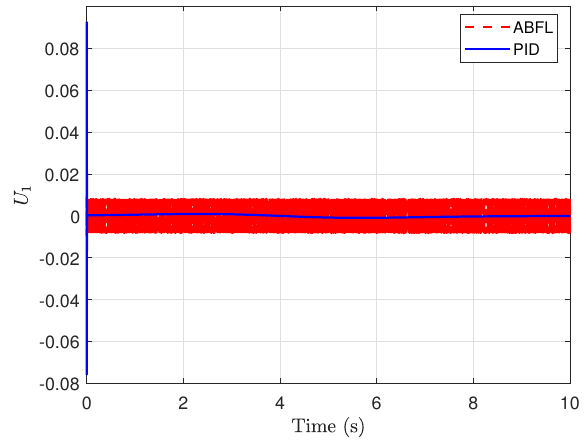
Figure 5. Control signal.